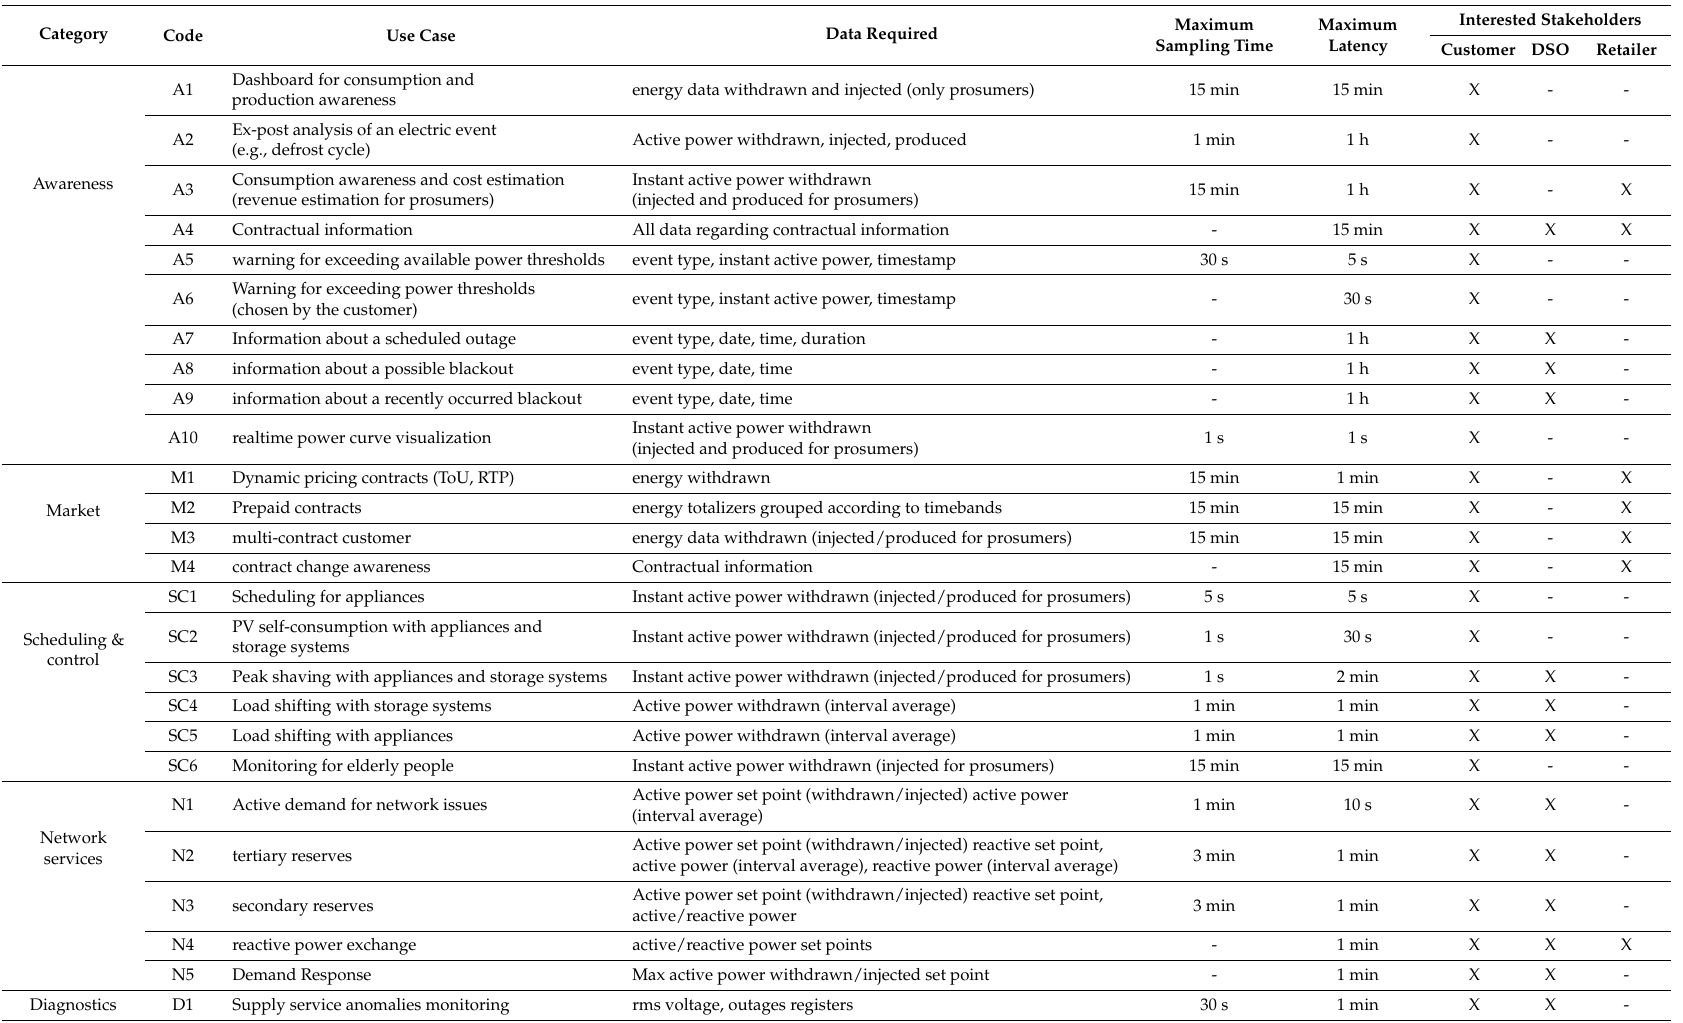
Table 2. Real-time services: time requirements and stakeholders